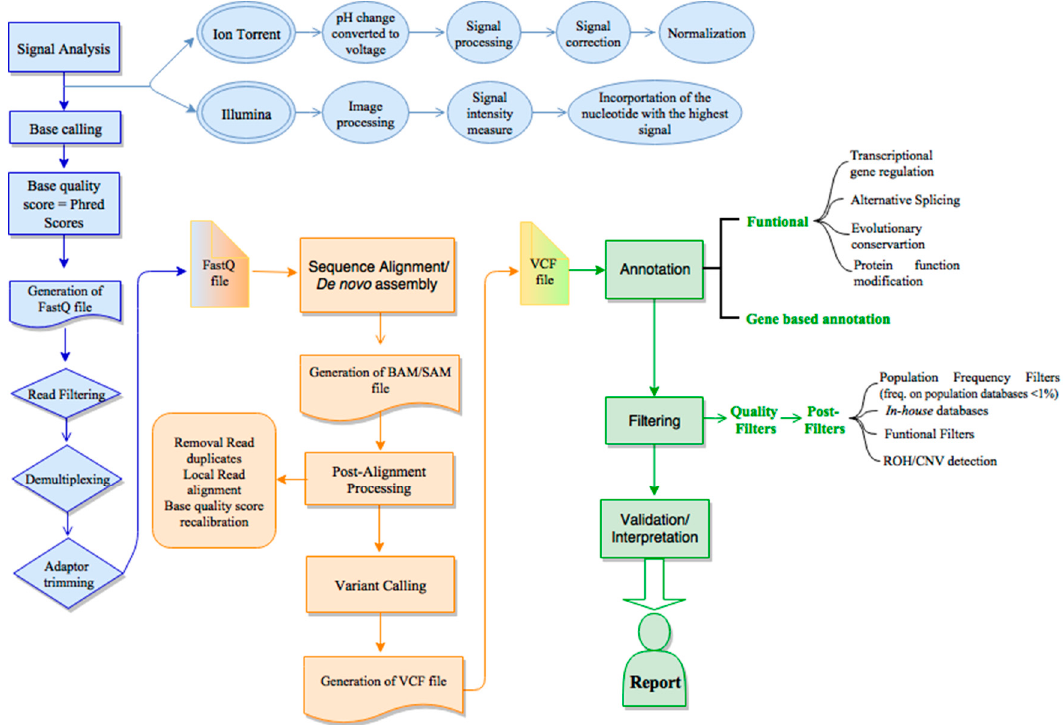
Figure 2. An overview of the next generation sequencing (NGS) bioinformatics workflow. The NGS bioinformatics is subdivided in the primary (blue), secondary (orange) and tertiary (green) analysis. The primary data analysis consists of the detection and analysis of raw data. Then, on the secondary analysis, the reads are aligned against the reference human genome (or de novo assembled) and the variant calling is performed. The last step is the tertiary analysis, which includes the variant annotation, variant filtering, prioritization, data visualization and reporting. CNV—copy number variation; ROH—runs of homozygosity, VCF—variant calling format.